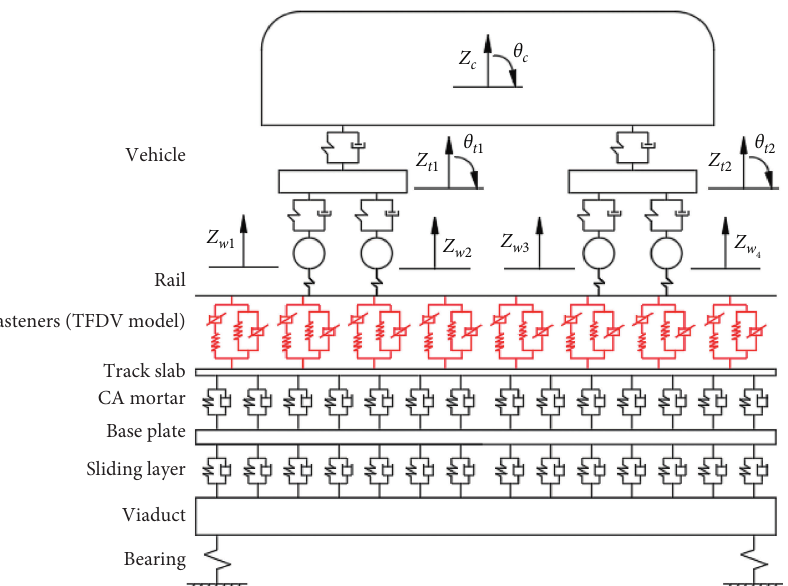
Figure 1: Vertical coupling vibration analysis of vehicle-rail-bridge.